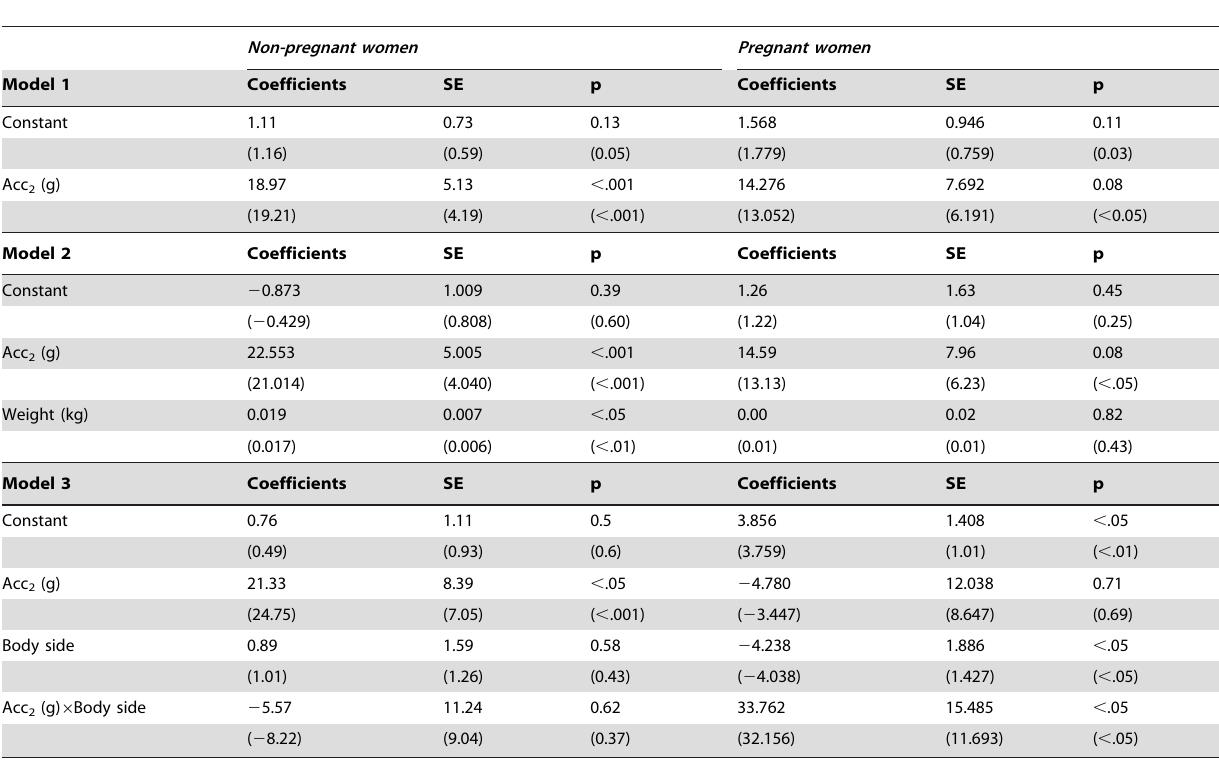
Table 3. Regression models for PAEE (MJ day 2 1 ) in non-pregnant and pregnant Swedish